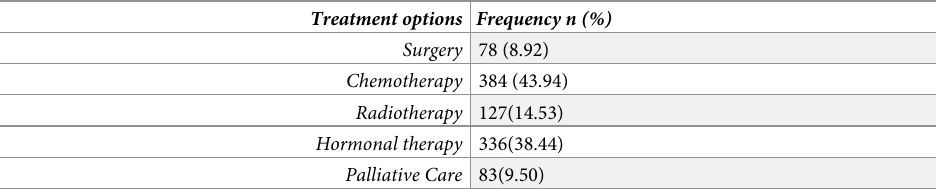
Table 3. Frequencies of patients on different treatment